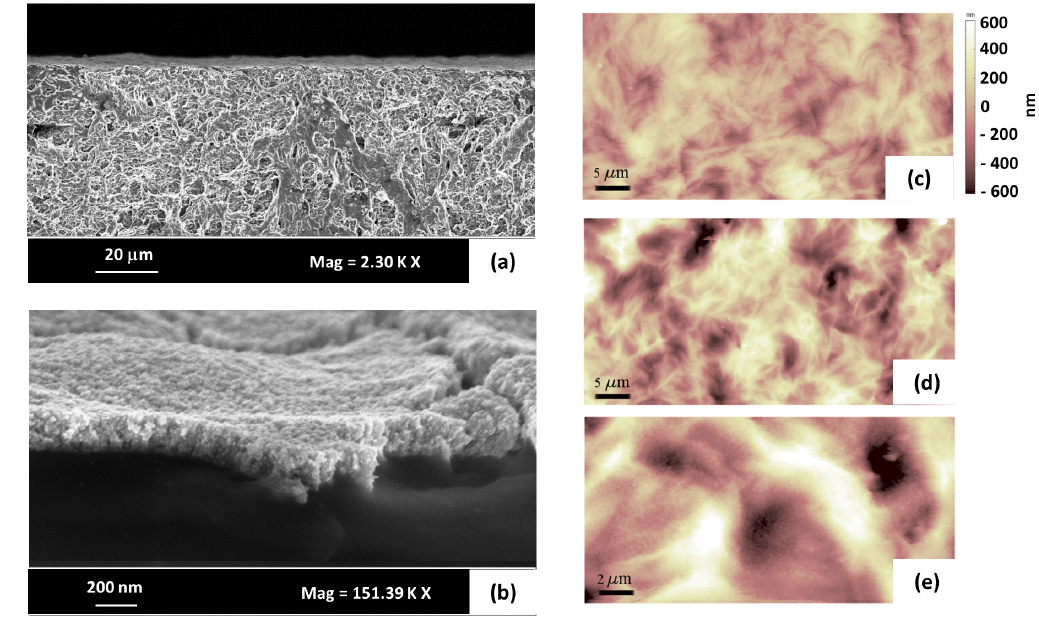
Figure 3. ( a ) Scanning electron microscopy (SEM) image showing the cross-section of supercapacitor BT1.7; ( b ) SEM image focusing on the electrodes cross-section; ( c , d ) atomic force microscopy (AFM) images of the ionogels surfaces BT1.7 and BT 2.9 (respectively); ( e ) AFM image of the gold surface deposited on top of the ionogel BT1.7.